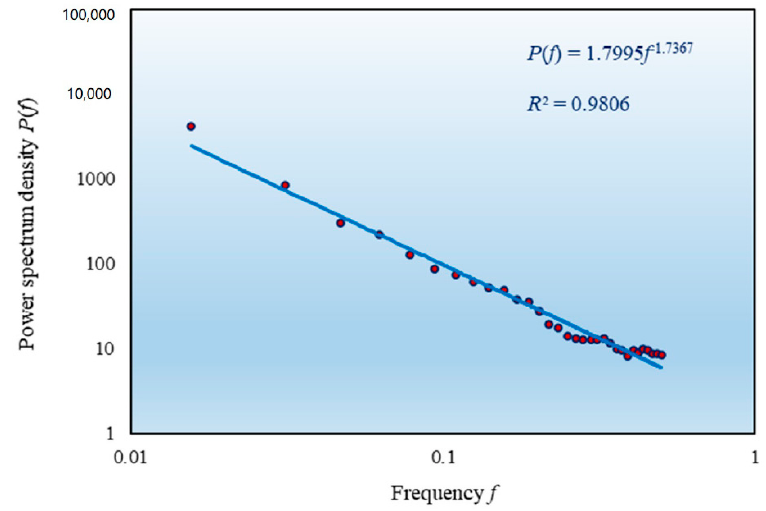
Figure 6. The power-spectrum scaling relations between frequency and power spectral density (1956–2019). Note: The time series comes between 1949 and 2019. The number of data points is N = 71. According to the requirement of FFT, the data point number must be N = 2 j +1 , where j = 0, 1, 3, . . . , int(ln N /ln(2)) ± 1. The best number is N = 64. So, the first 7 data points were removed to meet the needs of the algorithm.